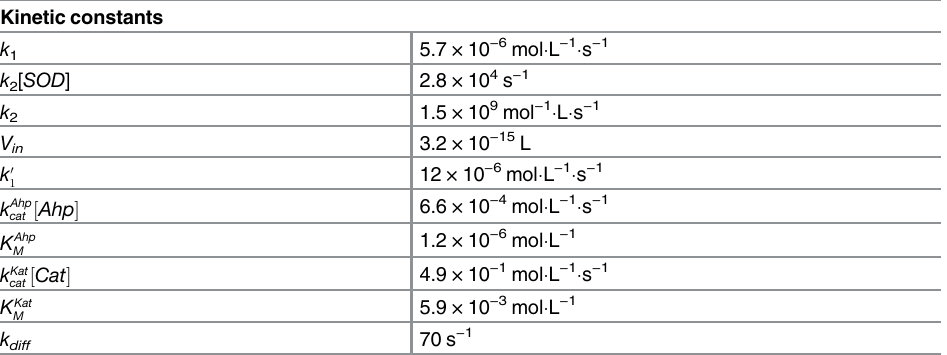
Table 1. Kinetic constants used to describe H 2 O 2 evolution. Kinetic